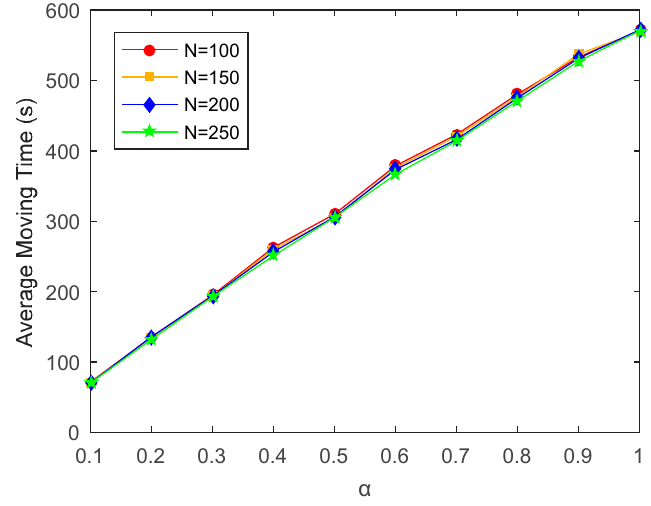
Figure 4. Impact of α on average energy consumption (P = 0.3 W). The lifetime is the round number when the first dead node appears. We found that the network lifetime increased with the increase of α in the range [0, 0.4], reaching the maximum when 0.4 α=